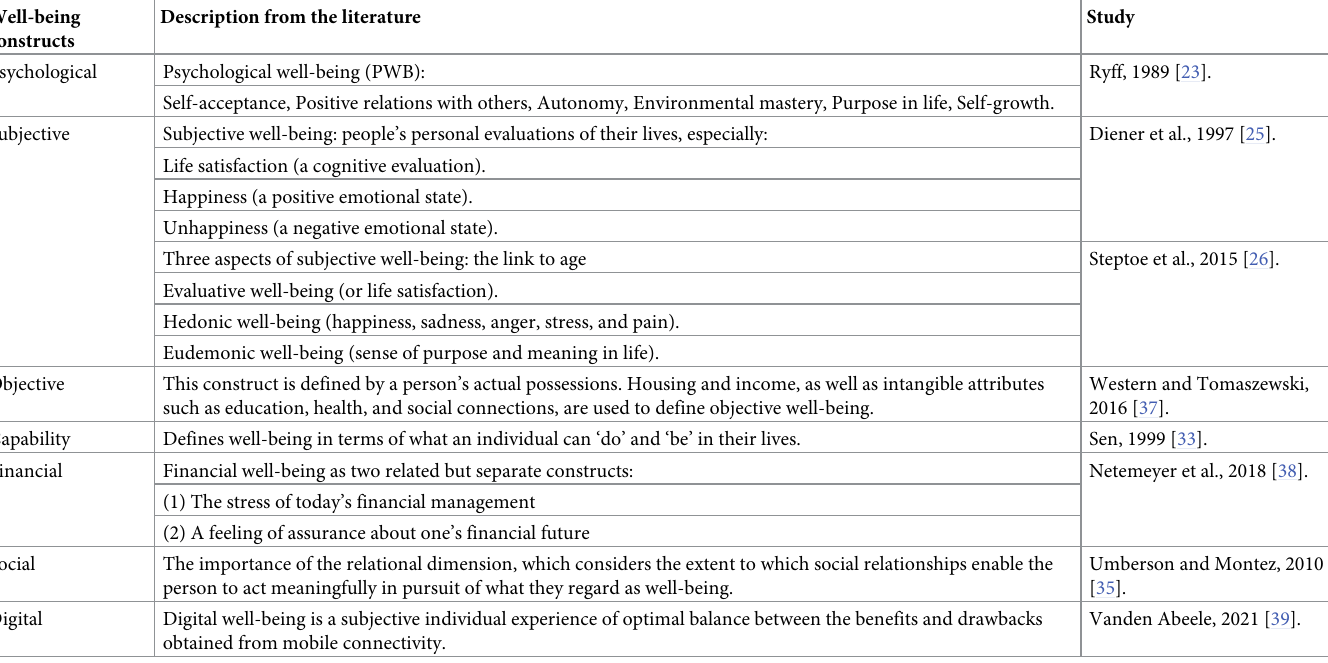
Table 1. Main constructs of well-being and their definitions from the